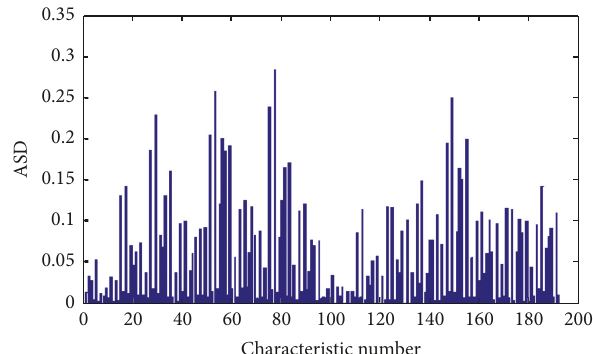
Figure 9: The ASD of 192 statistical characteristics of the training samples.